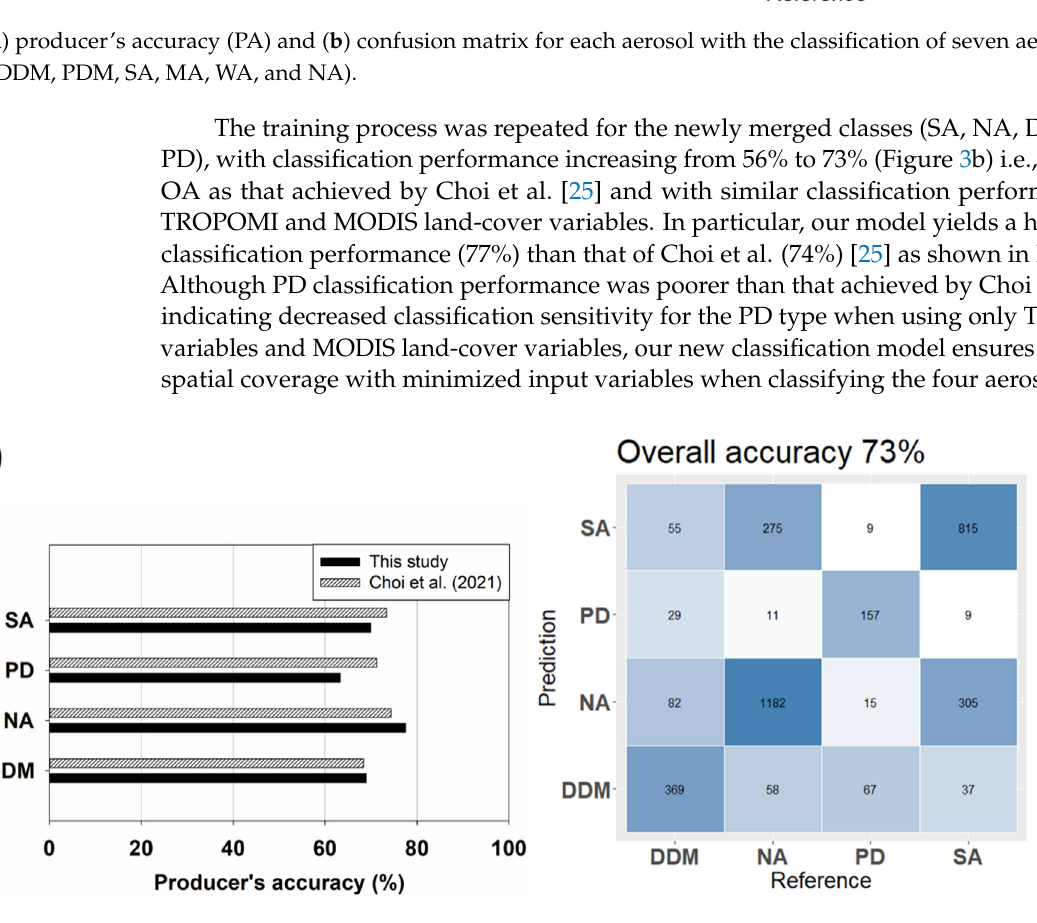
Figure 3. ( a ) PA and ( b ) confusion matrix for each aerosol in the classification of the four aerosol types (PD, DDM, SA, and NA).